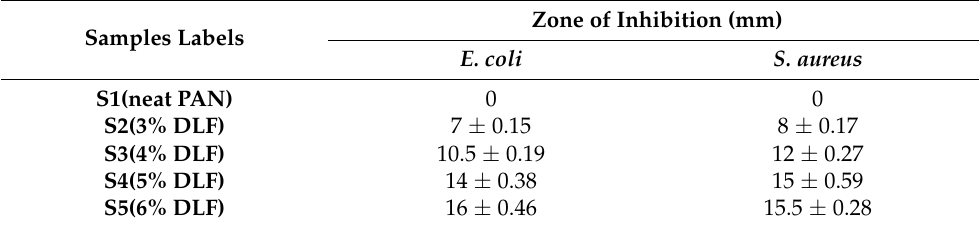
Figure 4. Bactericidal efficacy of DLF loaded PAN nanofiber (S2, S3, S4, and S5) using agar disc diffusion test ( A ) E. coli and ( B ) S. aureus . Table 2. Bacterial growth inhibition (zone of inhibition) for DLF loaded PAN